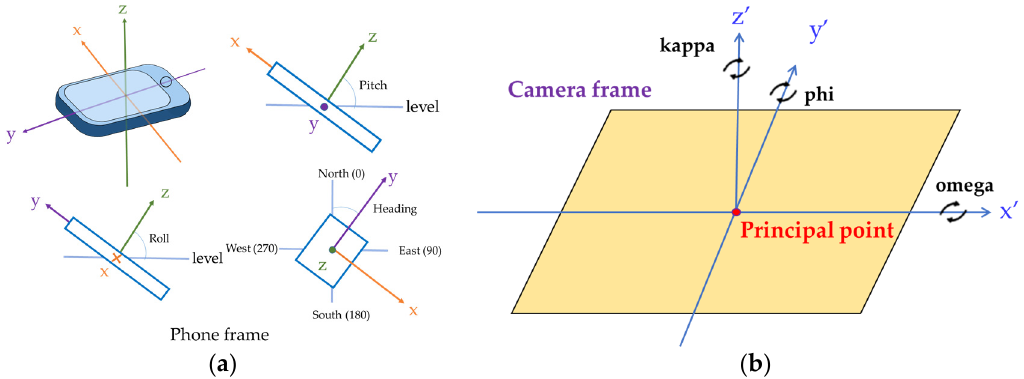
Figure 3. The spatial relationship: ( a ) the phone frame; ( b ) the camera frame.